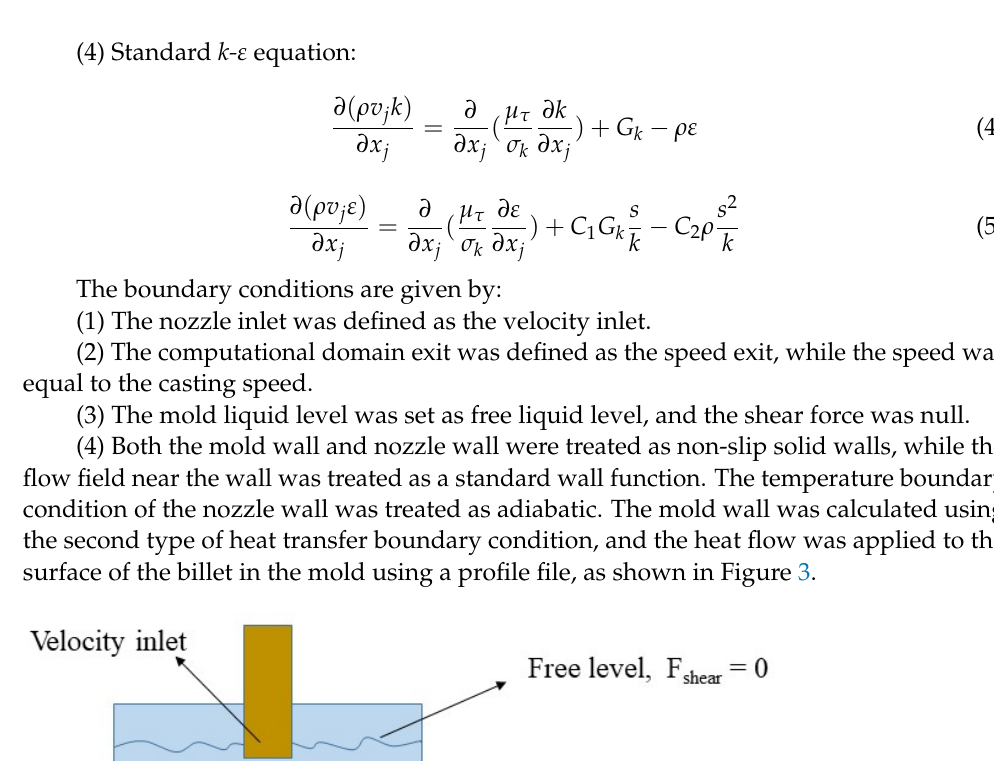
Table 1. Grid sensitivity analysis. Number of Grid